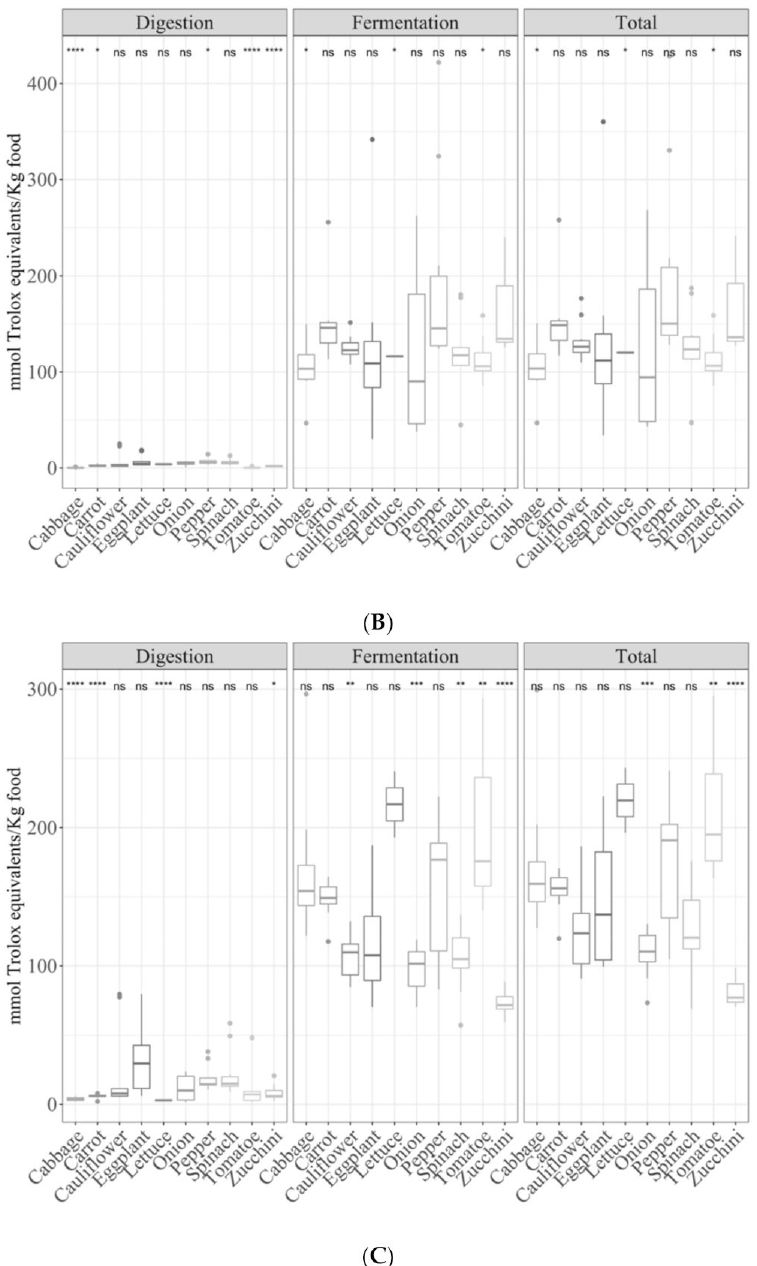
Figure 9. Antioxidant capacity of digested-fermented vegetables depending on sample type (( A ) for TEAC DPPH , ( B ) for Folin–Ciocalteu and ( C ) for TEAC FRAP ). Statistical analysis was performed via ANOVA using the mean of all food groups as the reference group. Statistic labels: *: p < 0.05, **: p < 0.01, ***: p < 0.001, ****: p < 0.0001, ns: not